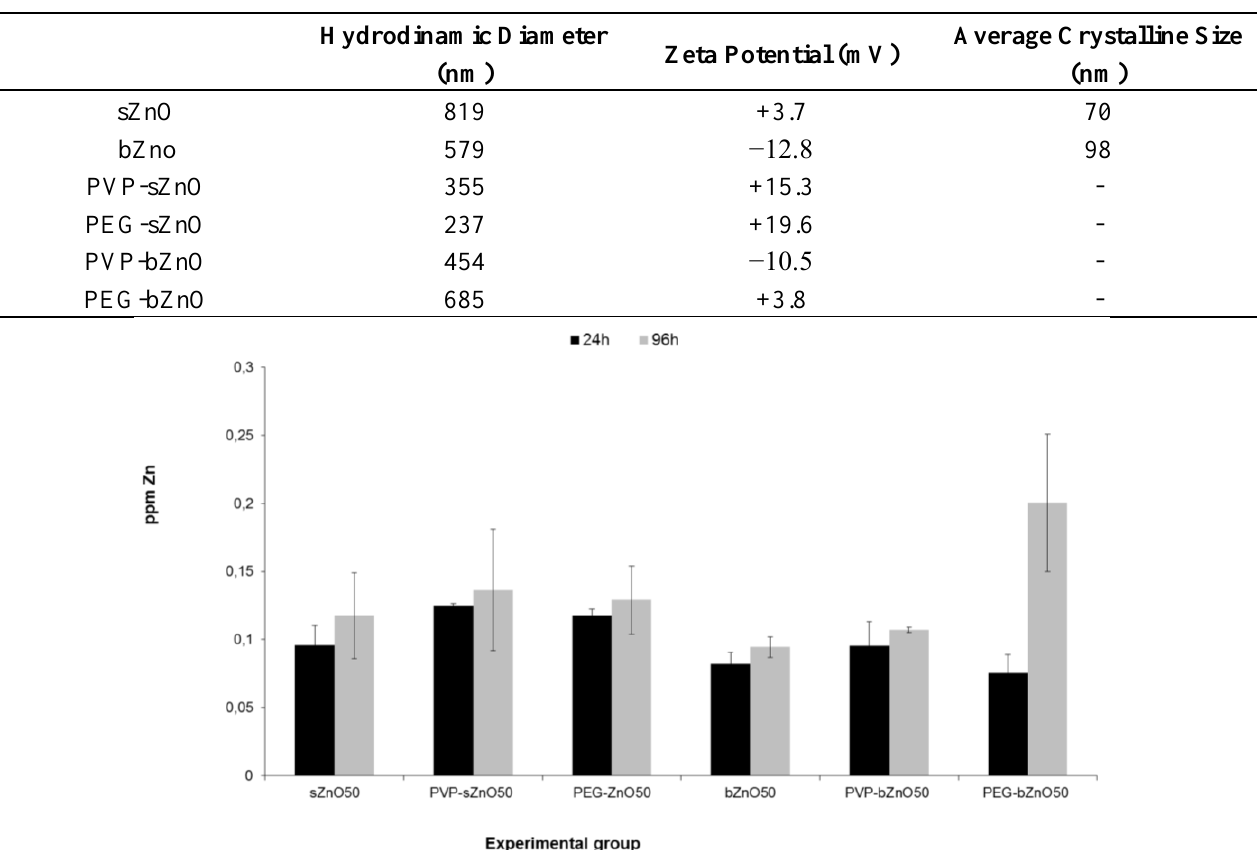
Table S1. Characterization by DLS of ZnONPs in FETAX medium and XRD analysis.